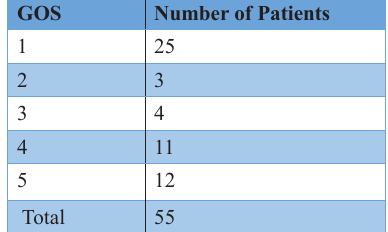
Table 3. Proportion of patients as per the GOS